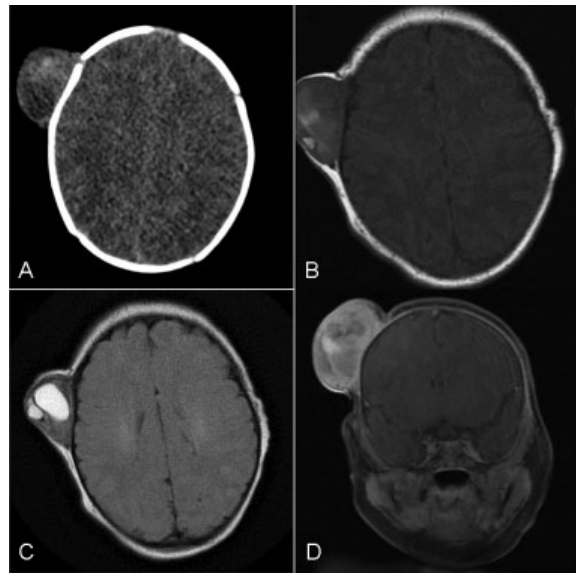
Fig. 1 Imagingstudiesdemonstratingright temporoparietalmass.( A )CTof the head — axial image demonstrates large-size extracalvarial mass. ( B ) Axial noncontrast T1-weighted MRI image. ( C ) Axial noncontrast MRI T2-FLAIR image. ( D ) Axial postcontrast MRI T1-weighed